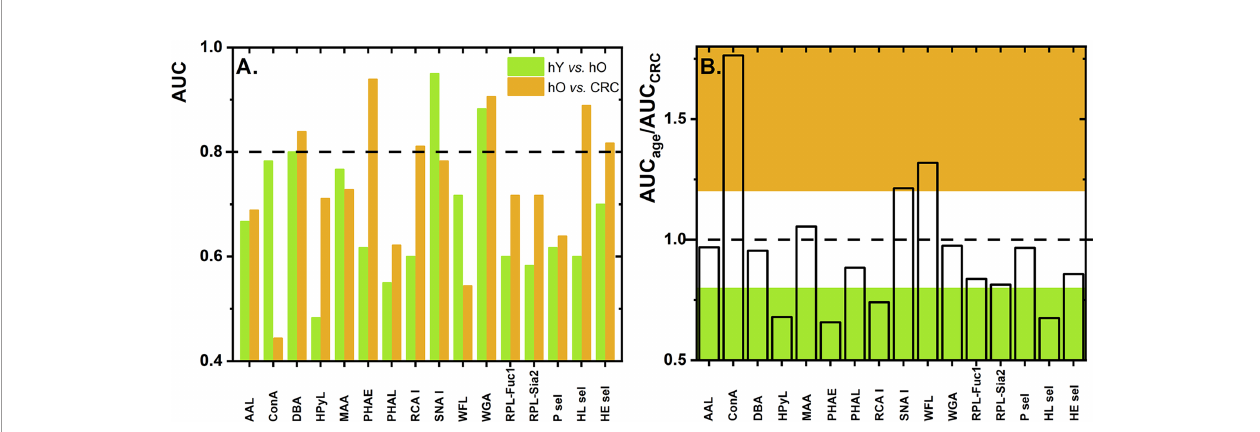
FIGURE 1 | Values of AUC for discrimination of the age matrix [healthy young (hY) vs. healthy old (hO) individuals] and the CRC matrix [hO vs. CRC patients] using single lectins (A) . The ratio of AUC age vs. AUC CRC as determined for single lectins with the ratio below 0.8 is shown in green and the ratio above 1.2 is shown in brown (B) . Standard deviation (SD) values are not shown for the better visual clarity of both fi gures.